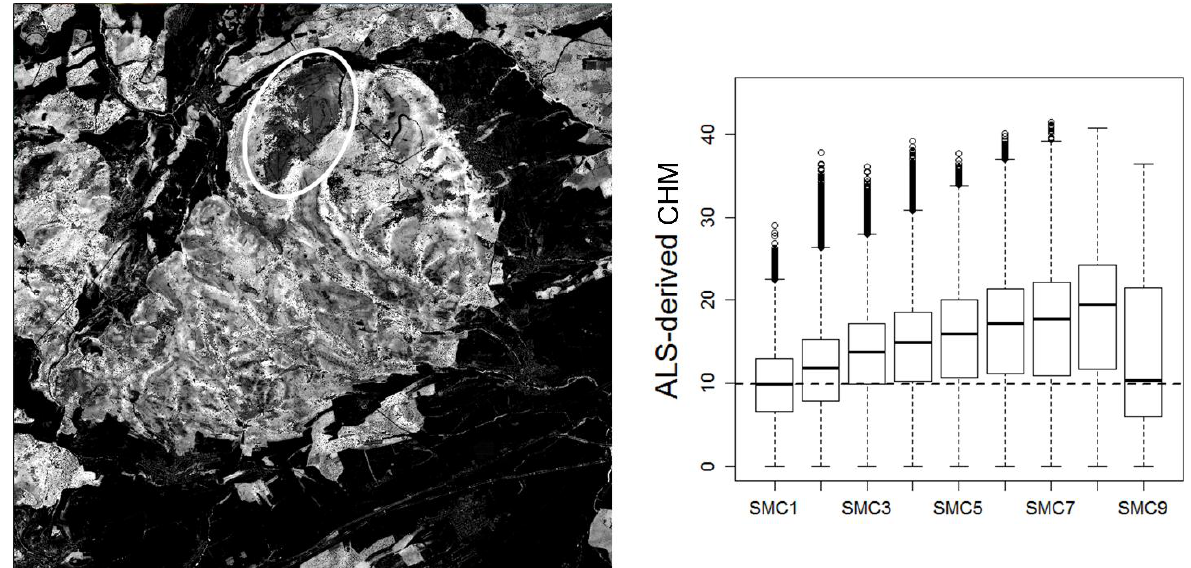
Figure 4. CHM derived from airborne laser scanning in 2010 ( left ) and a boxplot of the deciduous tree heights per SMC ( right ); the encircled area represents an area of extremely dense regrowth after a recent storm damage and, therefore, it has therefore been excluded from the analysis. The boxplots describe the median (black horizontal line inside the “box”) of the CHM in each SMC, upper and lower boundary of the box correspond to the 25 and 75% quantile and the end of the whiskers mark the data value which is at maximum 1.5 times the interquartile range from the box (smaller horizontal line at the end of the dashed